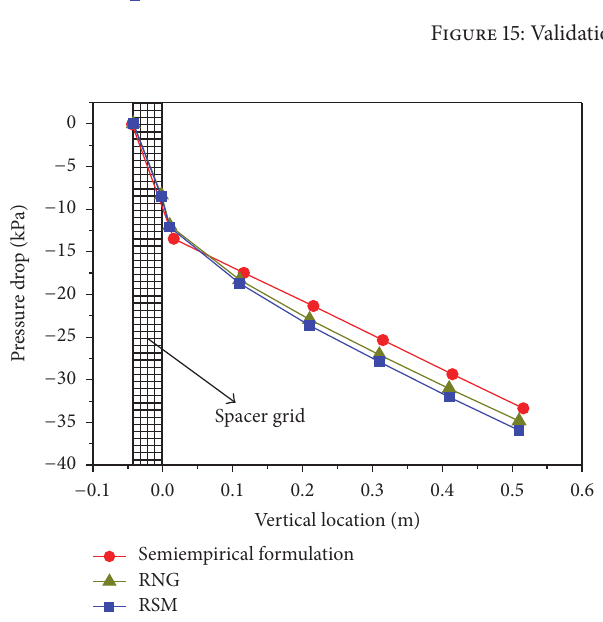
Figure 16: Validation for flow